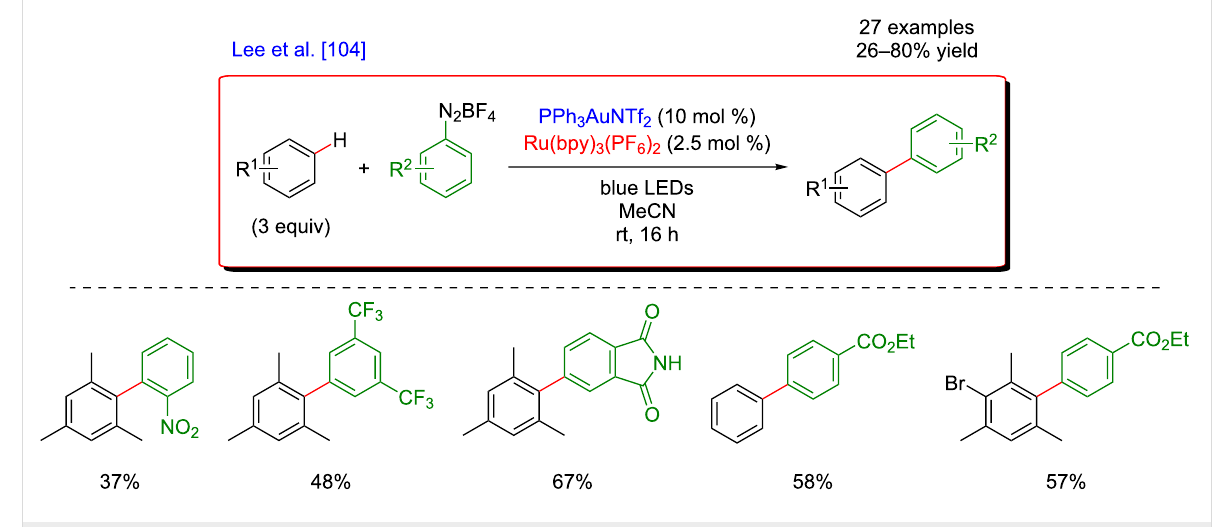
Figure 42: Undirected C–H aryl–aryl cross coupling via dual gold/photoredox catalysis.